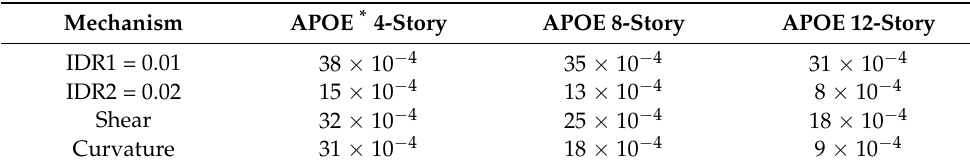
Table 5. Annual probability of limit state exceedance obtained for the three case study buildings through rigorous